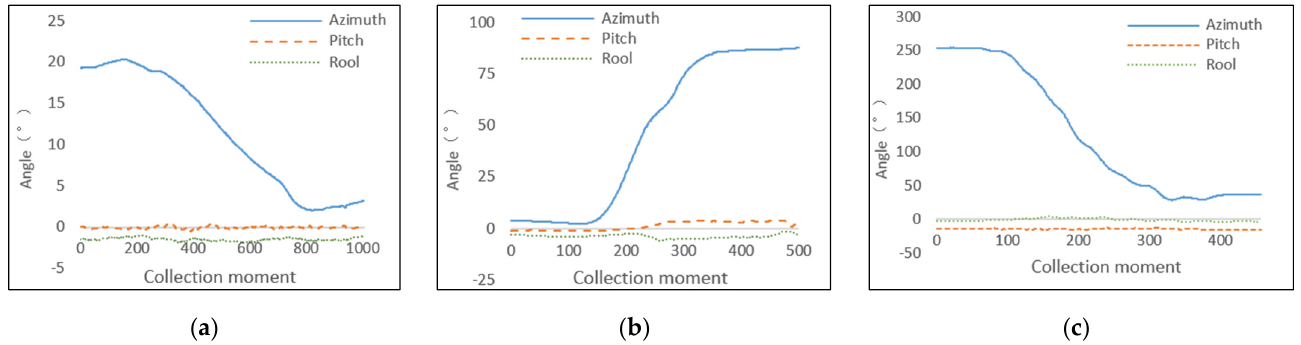
Figure 3. Change of the three-axis data of the direction sensor during the process of turning: ( a ) a 20° left turn; ( b ) a right 90° turn; ( c ) a 180° turn.